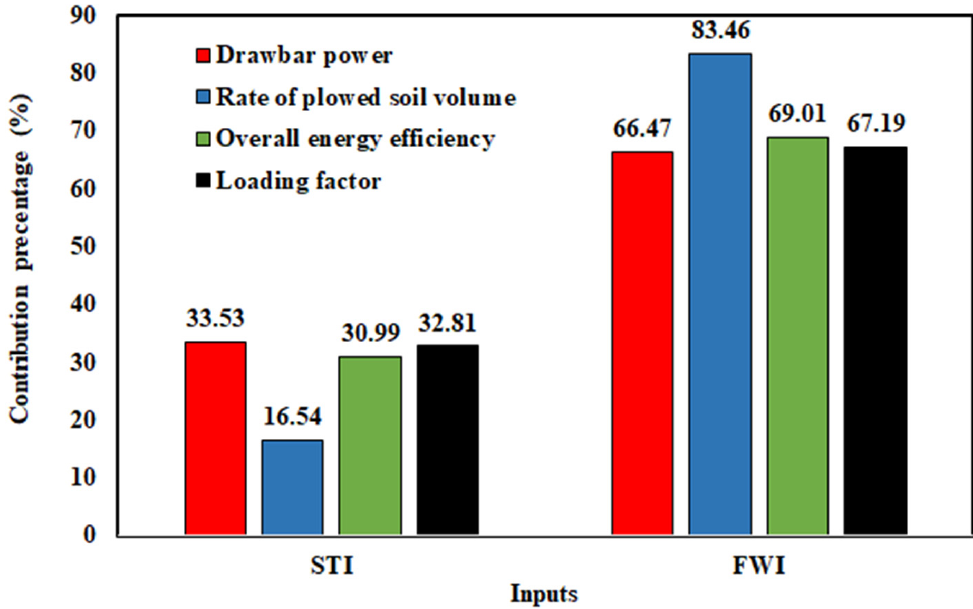
Figure 13. Contribution percentages of the input parameters (STI and FWI) to the performance attributes of drawbar power, overall energy efficiency, rate of plowed soil volume, and loading factor using ANN model.